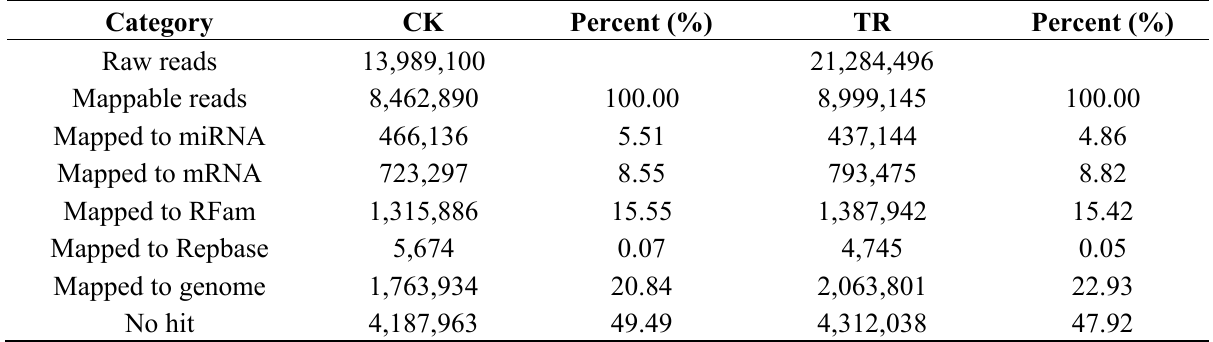
Table 1. Statistical analysis of sequencing reads in the two